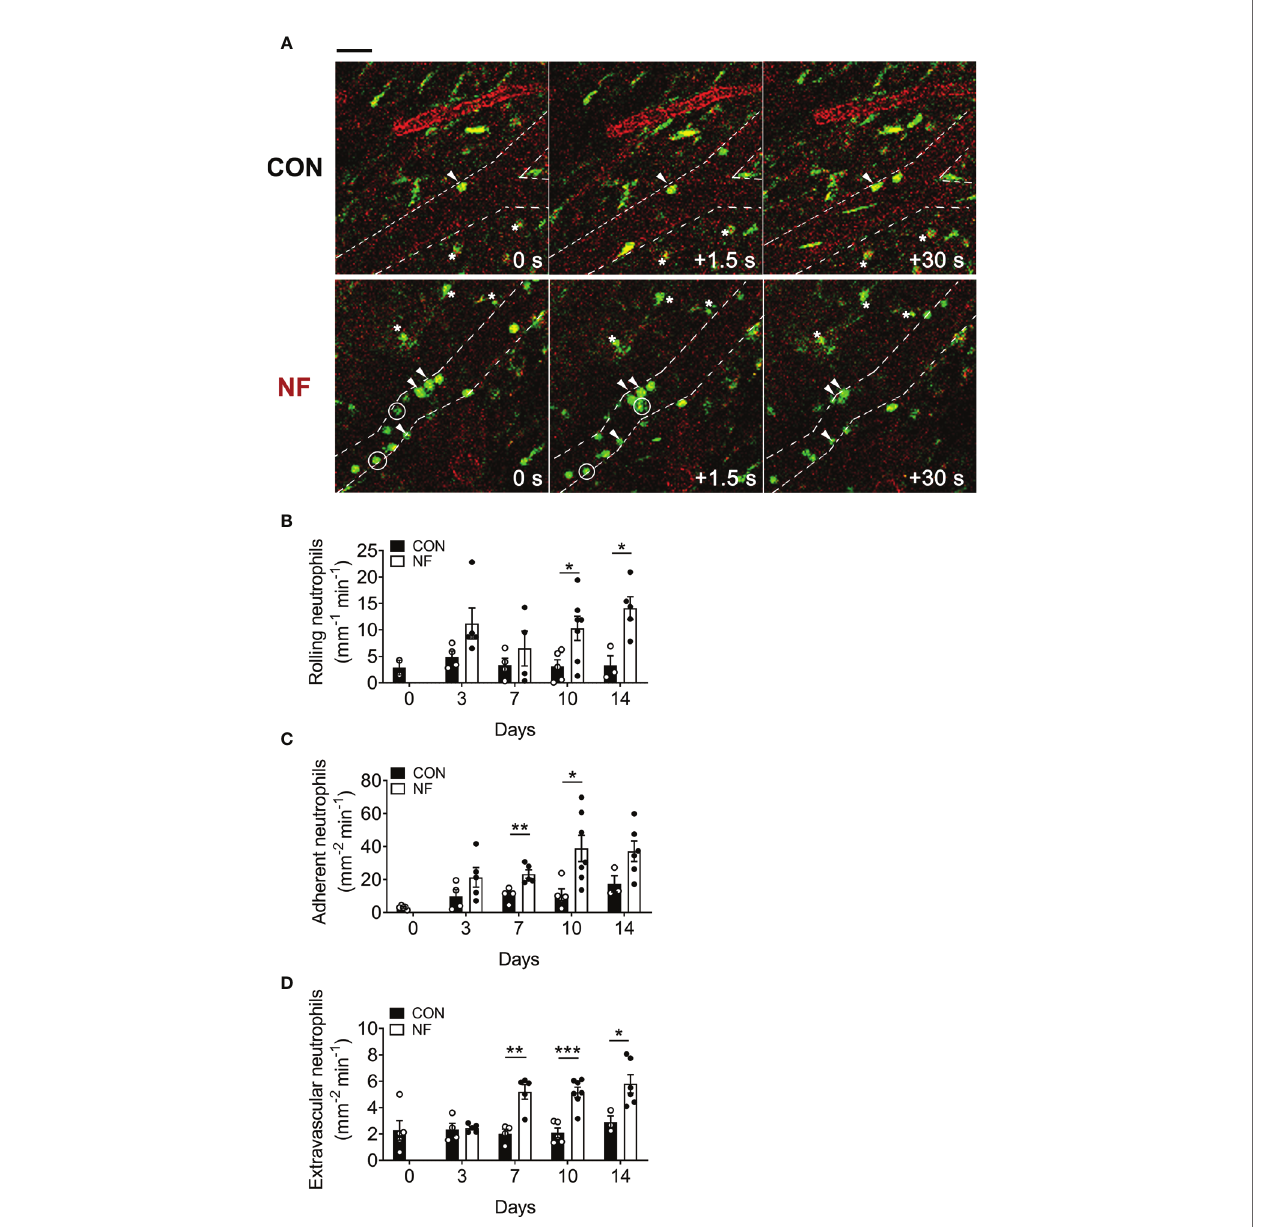
FIGURE 3 | No- fi ber diet promotes the recruitment of neutrophils to the colon. LysM eGFP mice were fed CON or NF diet for 14 days. At days 0, 3, 7, 10, and 14, LysM eGFP mice were anesthetized, injected with PE-conjugated anti-CD31 to label the endothelium, and intravital microscopy of the colon was performed. (A) Representative image sequences taken at day 14 of CON or NF diet feeding, showing neutrophils that are rolling (circled), adherent (arrowhead), and extravascular (asterisk). Scale bar = 50 m m. The number of (B) rolling, (C) adherent, and (D) extravascular neutrophils were enumerated. Data displayed as mean ± SEM. Dots represent individual mice, N ≥ 3 per group per timepoint. Student ’ s t -test was performed, * P < 0.05, ** P < 0.01, *** P <